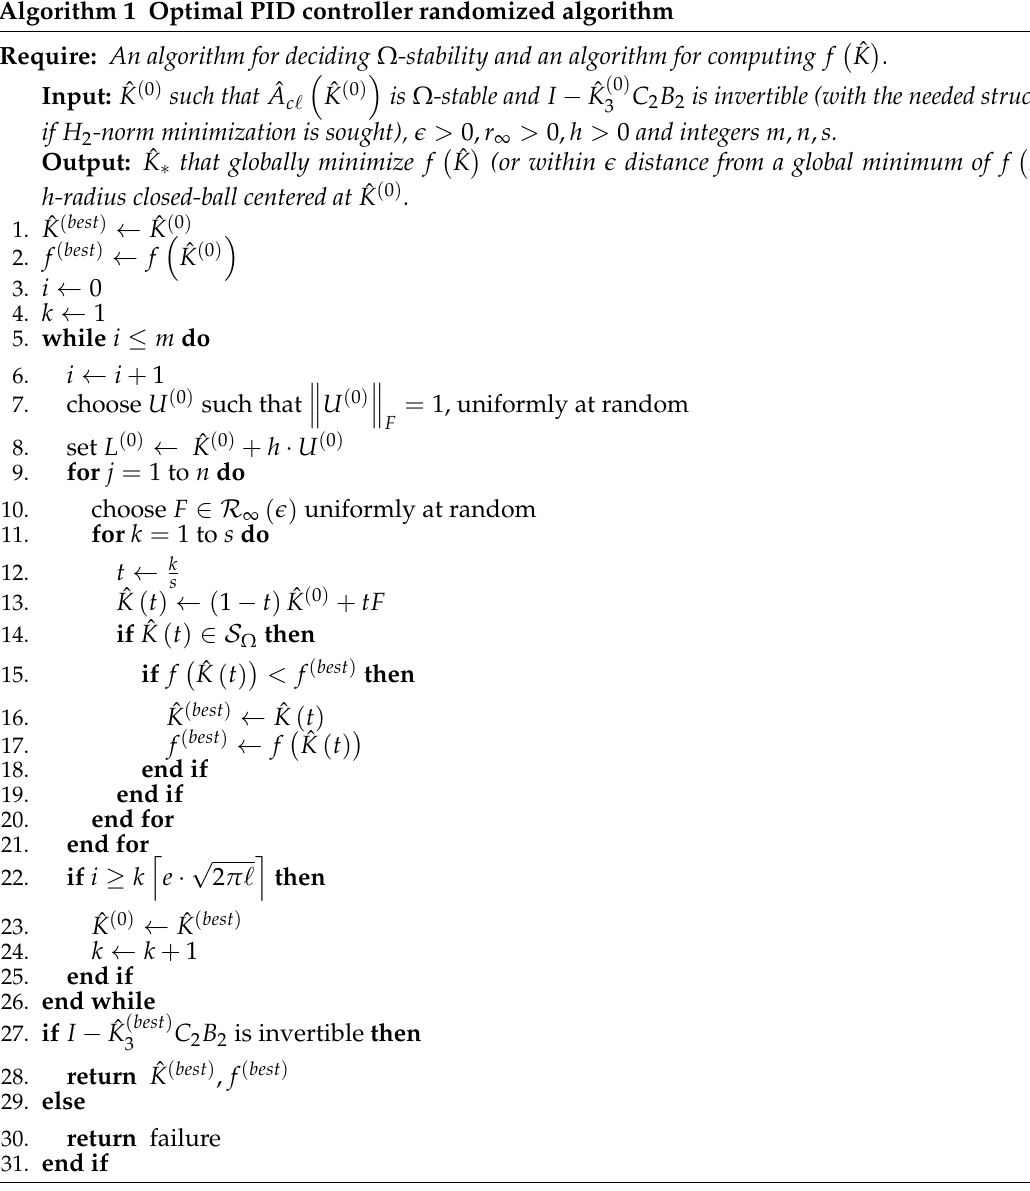
Algorithm 1 Optimal PID controller randomized